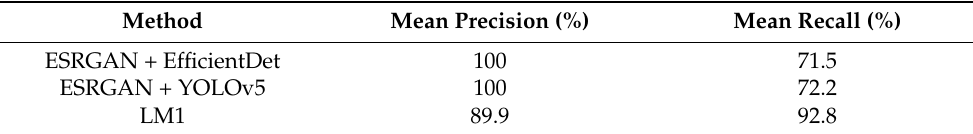
Table 2. Comparative evaluation of the proposed ESRGAN + YOLOv5 and ESRGAN + EfficientDet with Dhiman and Klette [57] best-performing model (LM1) on selected frames from the CCSAD dataset.